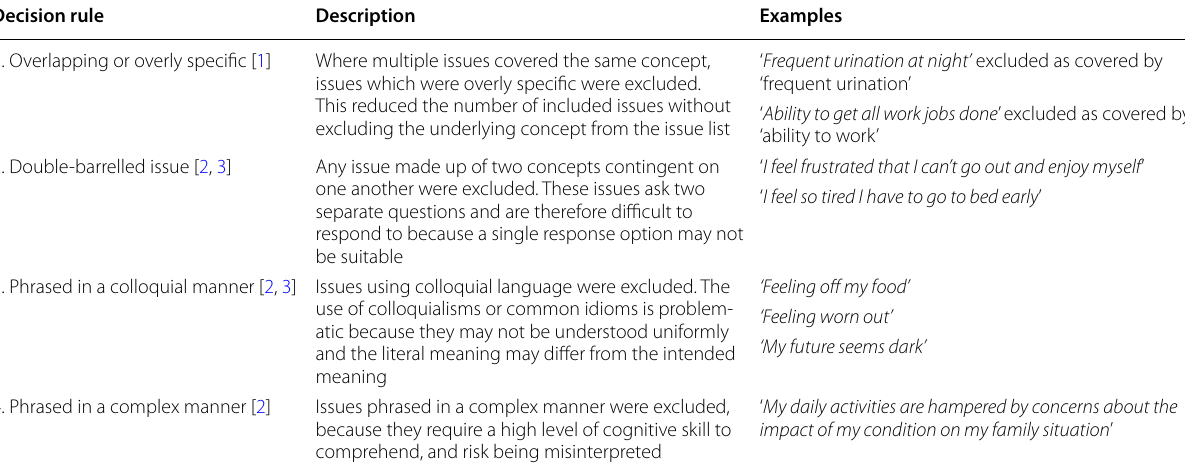
Table 3 Stage 1 decision rules for excluding issues from the full issues list Decision